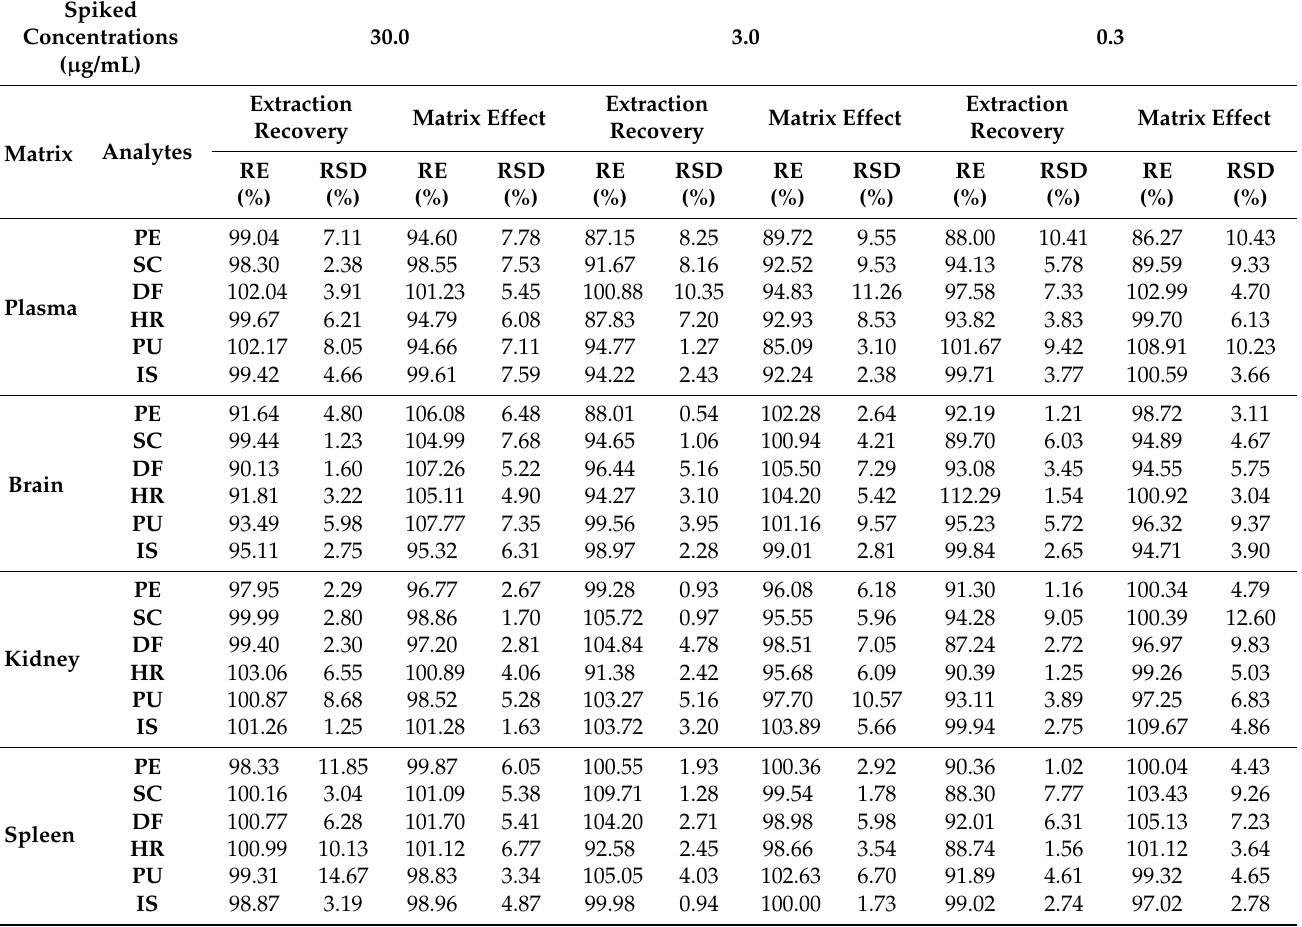
Table 3. Data of extraction recovery and matrix effects determined for coumarins in plasma and tissue